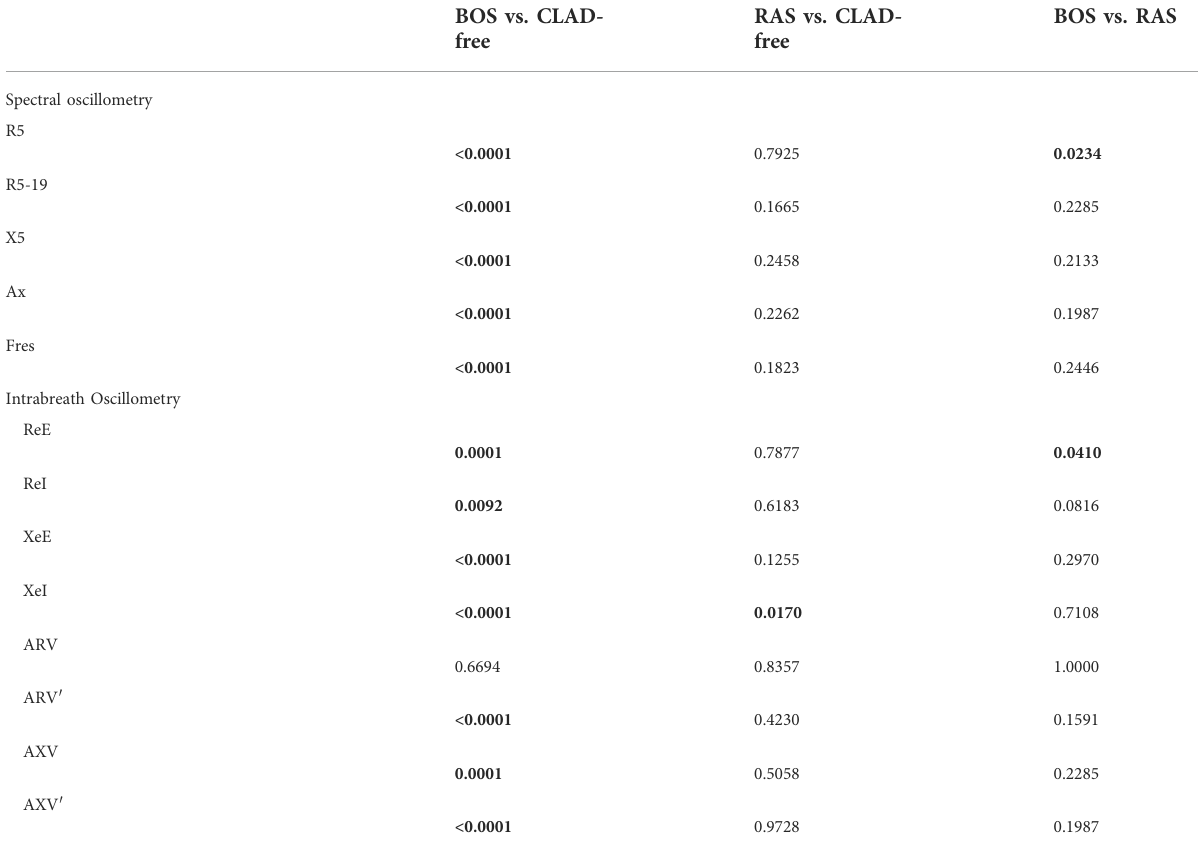
TABLE 3 Table of p -values from paired comparisons with Wilcoxon signed rank test with Bonferroni correction for multiple comparisons.